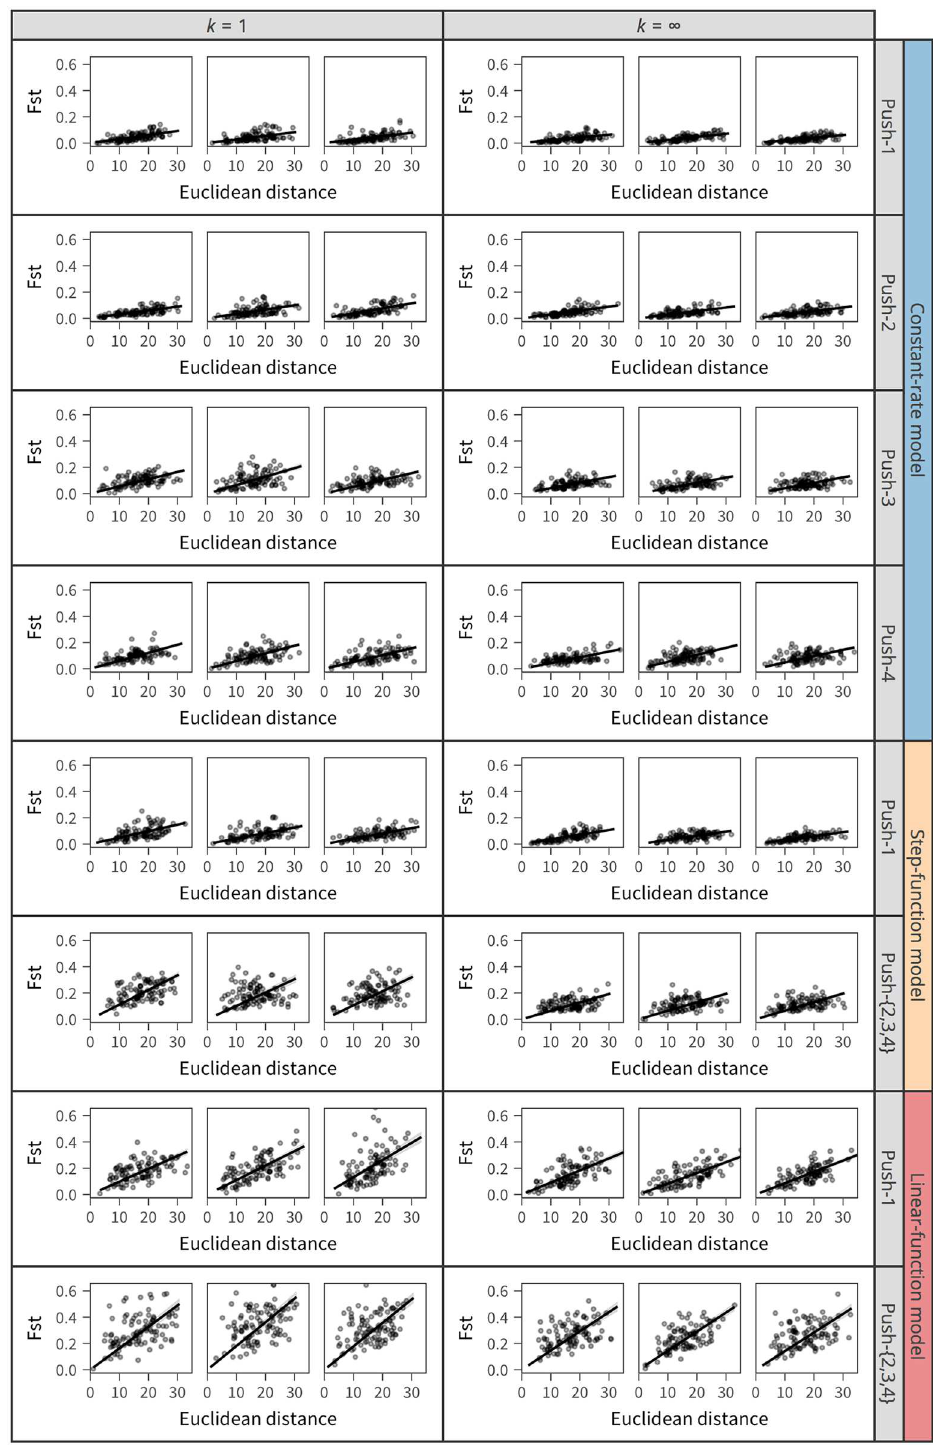
Fig 9. Correlation between F ST and physical distance measuredby Euclidean distance. The simulated tumors shown in Fig 8 are used.